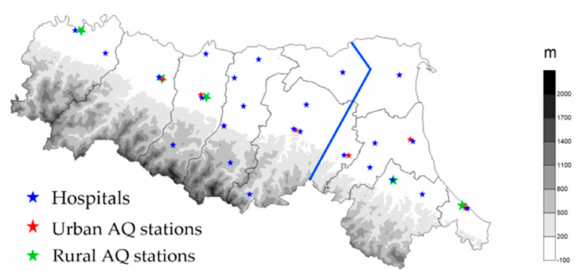
Figure 1. Map of the Emilia-Romagna Region. The blue stars indicate the location of Emilia-Romagna Hospitals, red stars mark the location of urban air quality stations, while green stars indicate the location of rural air quality stations. On the right is the Adriatic sea, on the south west is the Tyrrhenian sea, while the Po river flows from west to east parallel to the northern border of the region. The thick blue line is the border between Emilia and Romagna.